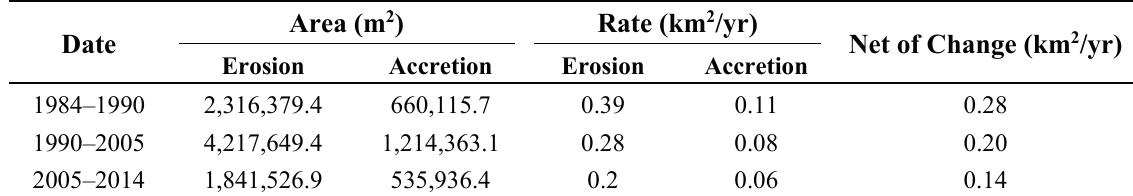
Figure 7. The classified binary images for ( A ) 1984, and ( B ) 2014 for Rosetta Promontory. Table 3. Accreted and eroded areas at Rosetta Promontory between 1984 and 2014 using histogram threshold of Band